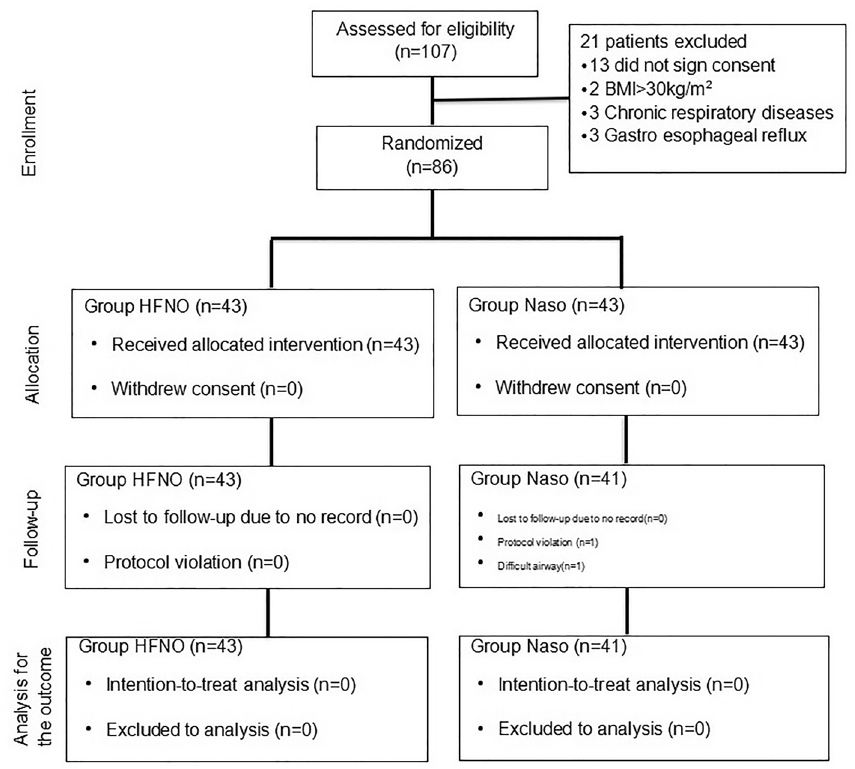
Figure 2. CONSORT flow chart.